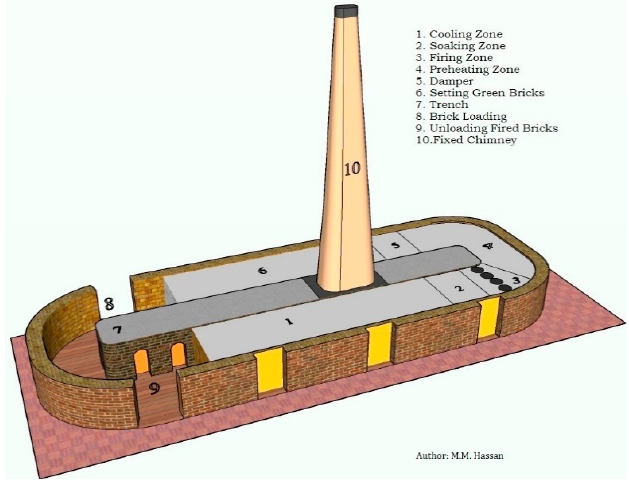
Figure 2. Schematic diagram of traditional fixed-chimney Bull trench clay-made brick burning kilns.